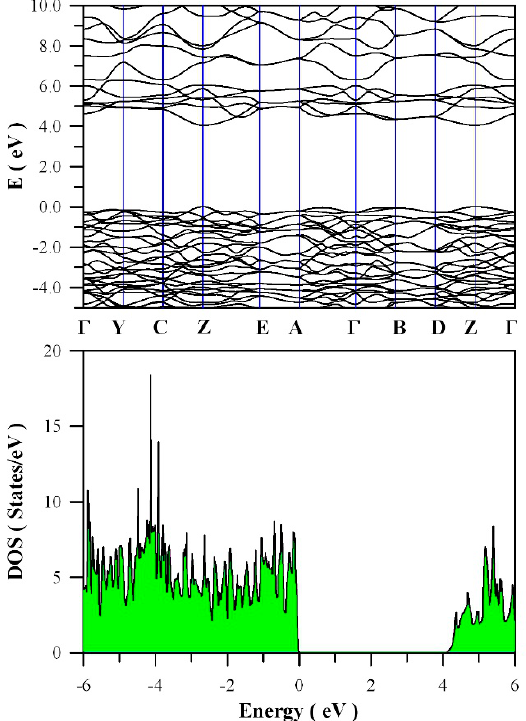
Figure 11. DFT calculated electronic structures for defect-free ZnWO 4 : ( a ) band structures; ( b ) density of states.